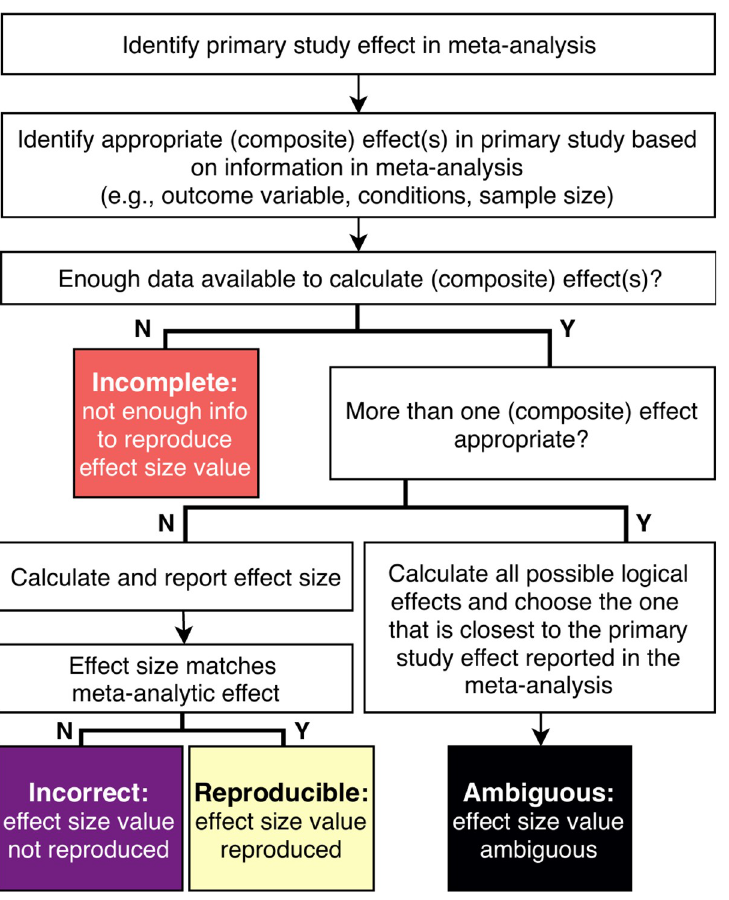
Fig 1. Decision tree of primary study effect size recalculation and classification of discrepancy categories. A composite effect refers to a combination of two or more effects.